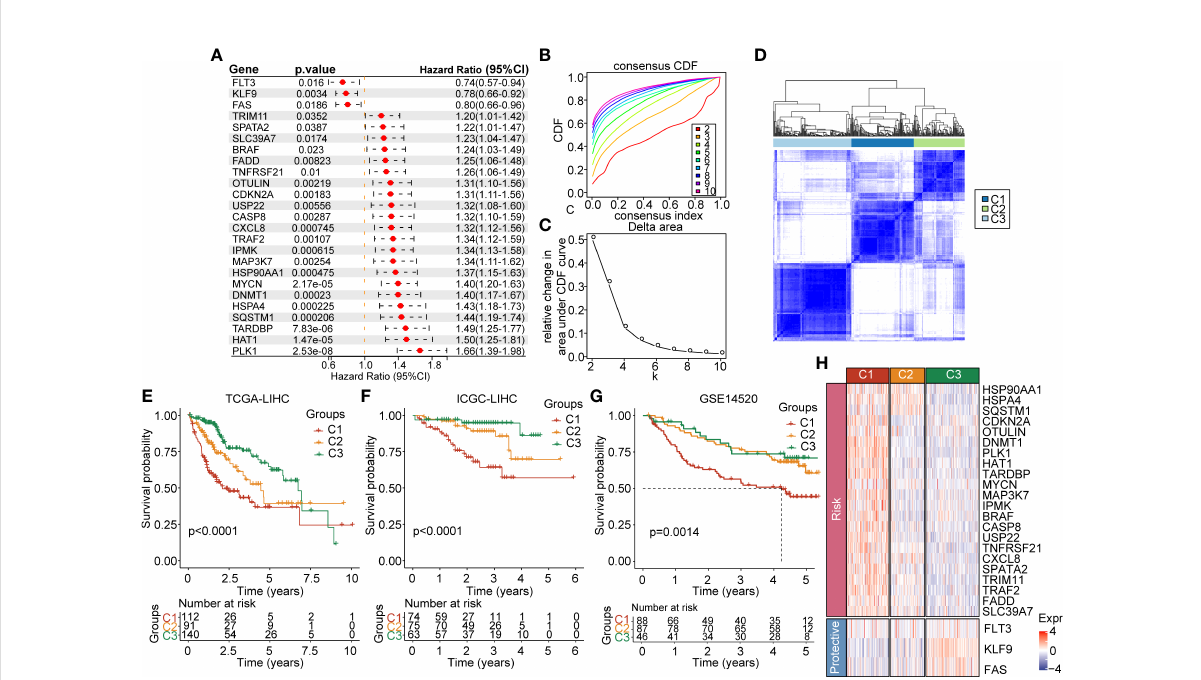
FIGURE 1 Expression landscape of necroptosis-based genes in the TCGA-LIHC cohort. (A) Forest map of necroptosis-related genes with prognostic signi fi cance in the TCGA-LIHC cohort. (B) CDF curve of the TCGA-LIHC cohort samples. (C) Delta area curve of consensus clustering, which indicates the relative change in area under the CDF curve for each category number k = 2 to k = 10. (D) Heatmap of consensus matrix k = 3 in the TCGA-LIHC cohort. (E) KM curve of overall survival in three clusters of the TCGA-LIHC cohort. (F) KM curve of overall survival in three clusters of the ICGC cohort. (G) KM curve of overall survival in three clusters in GSE14520 dataset. (H) Heatmap of expression of necroptosis genes in 3 clusters of the TCGA-LIHC